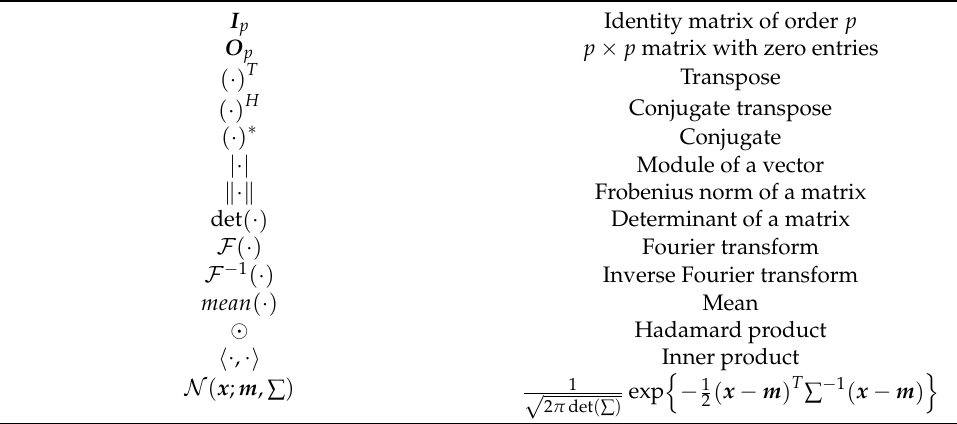
Table 1. Table of notations. I p Identity matrix of order